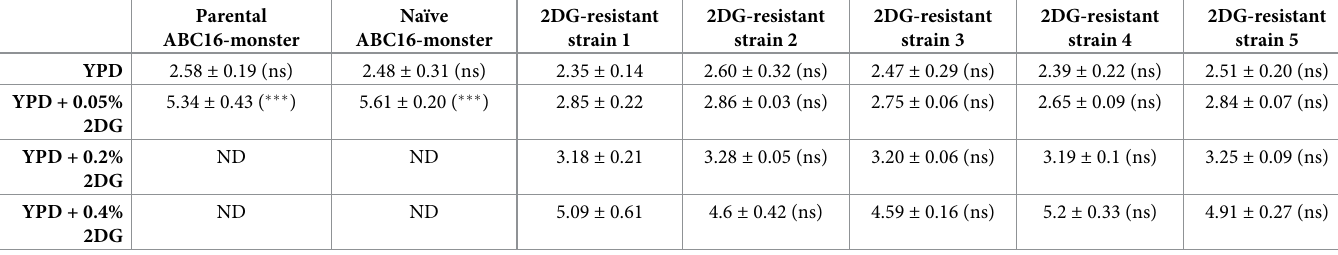
Table 1. Doubling times calculated from the growth curves shown in Fig 2B